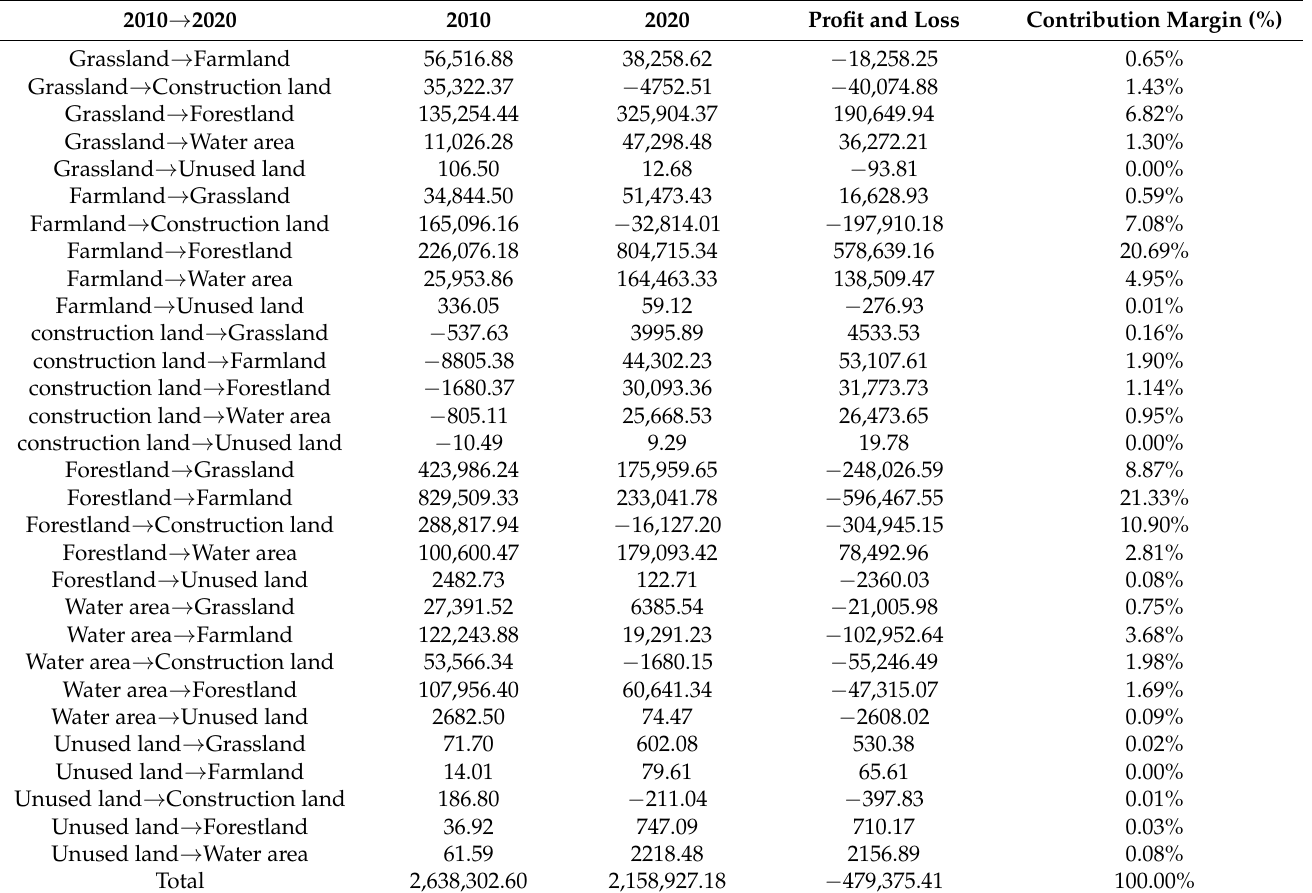
Table 3. Effect of land consolidation before and after on the number of ecological values (10 4